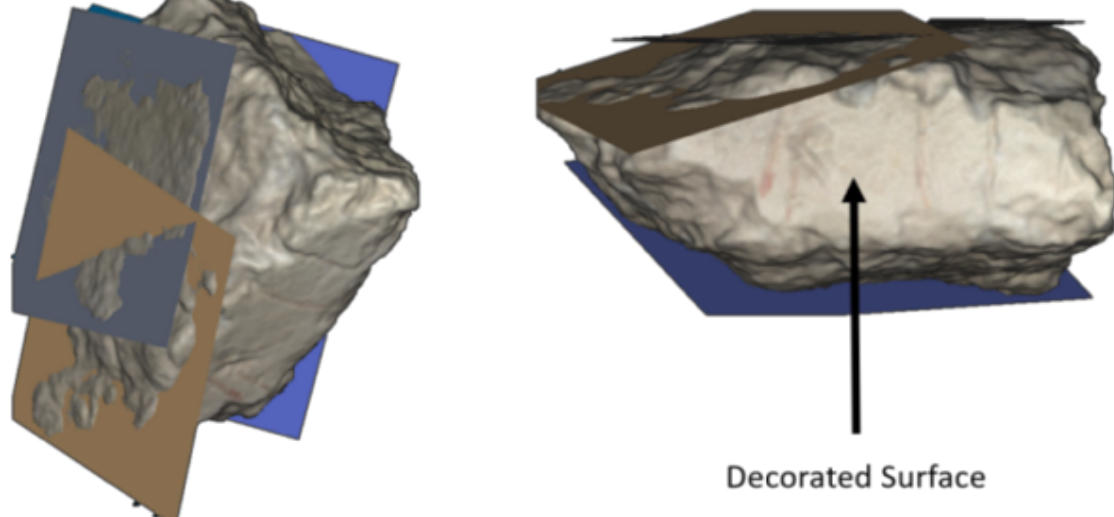
Figure 2. Example of a case where RANSAC struggles to find the decorated surface due to the irregular shape of the fragment.